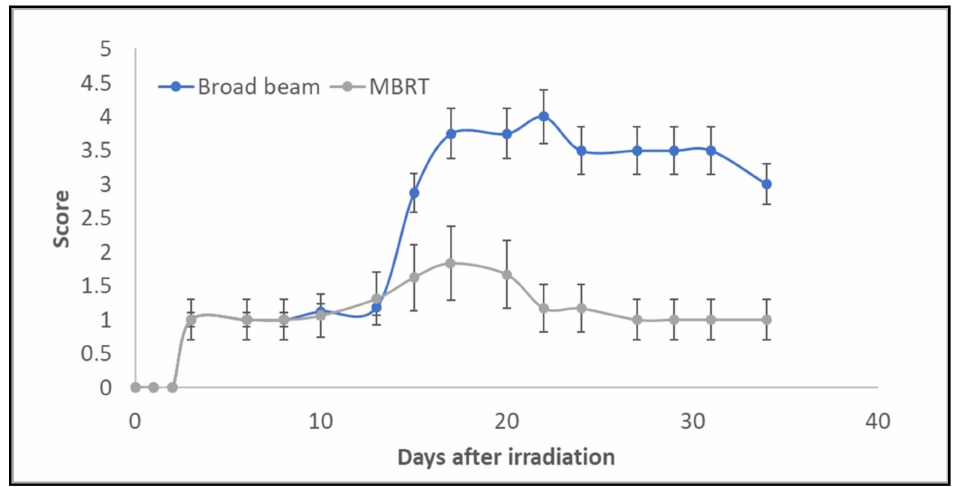
Figure 5. Evaluation of average skin damage scores as a function of follow up time and irradiation mode. Mean and standard deviation values are represented in the plot.